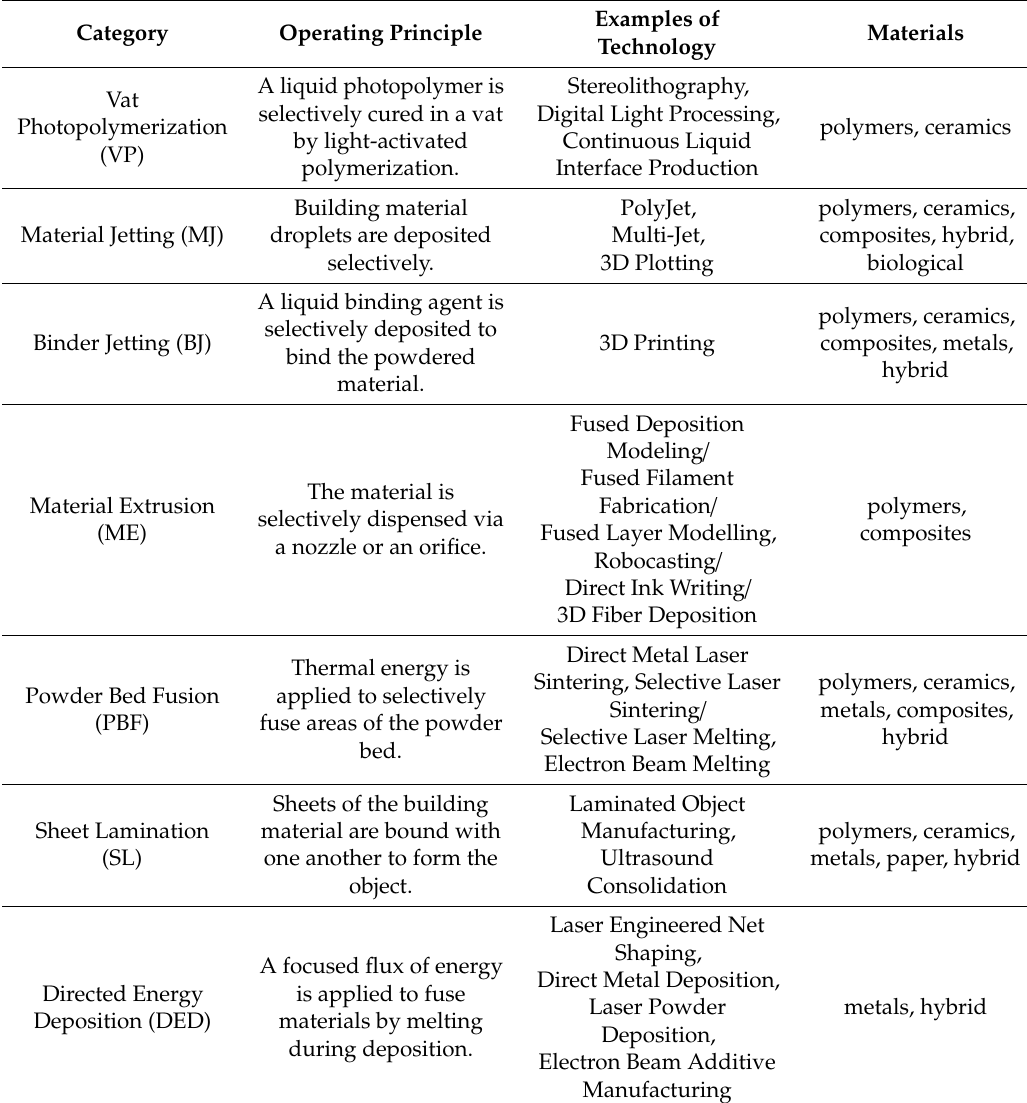
Table 1. Additive manufacturing classification by ASTM International